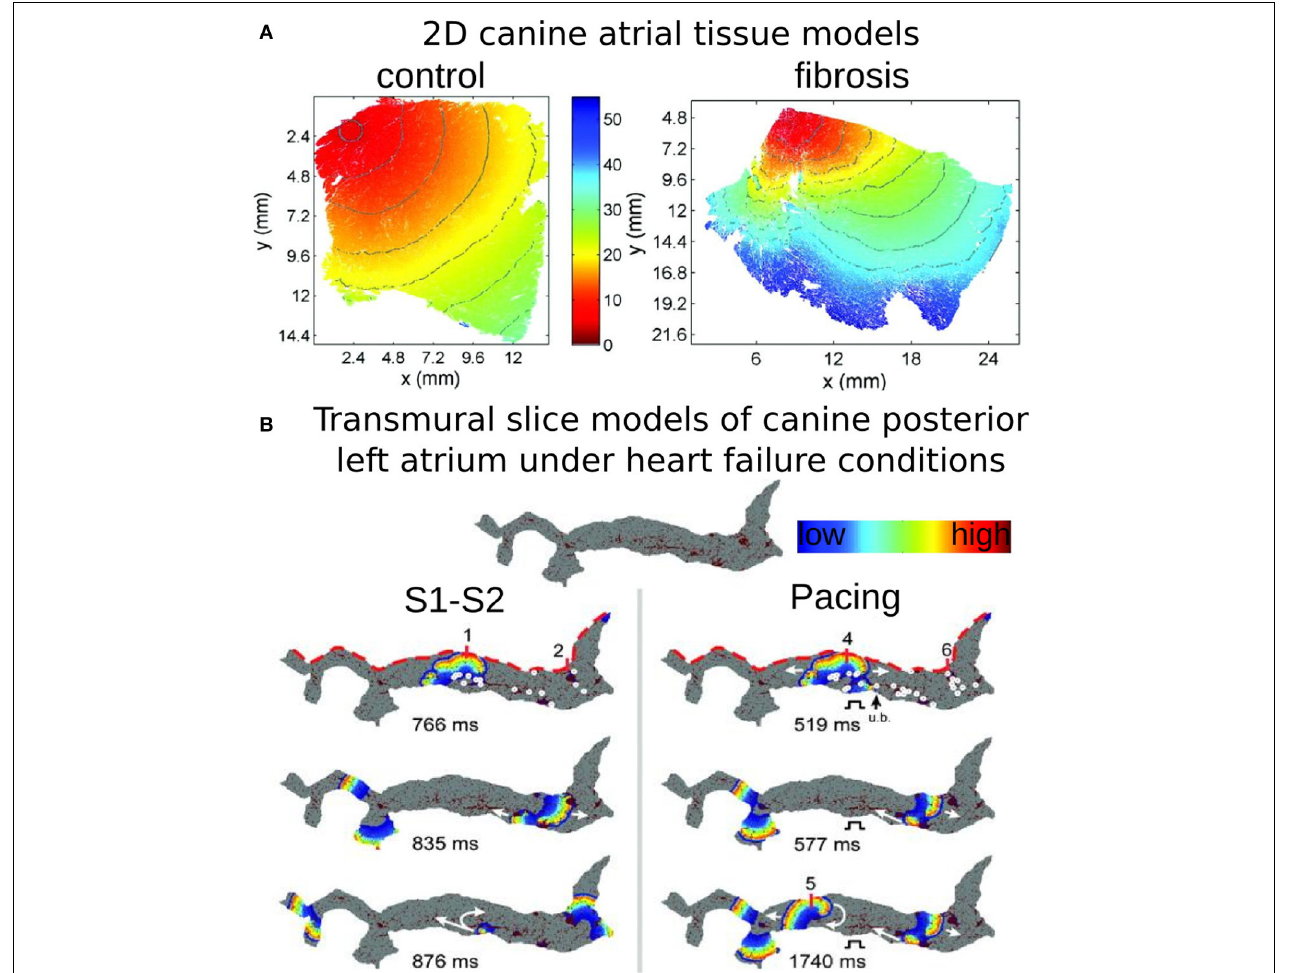
FIGURE 3 | Modeling fibrosis as regions of collagen presence. Collagen is represented as an insulator. (A) Simulations of propagation in models of 2D tissue sections of canine atrium (control, left, and fibrosis, right). With permission from Burstein et al. (2009). (B) Simulations in models of a transmural slice of canine posterior LA under HF conditions; the top of the slice (red dashed lines) corresponds to the epicardial surface. Snapshots at